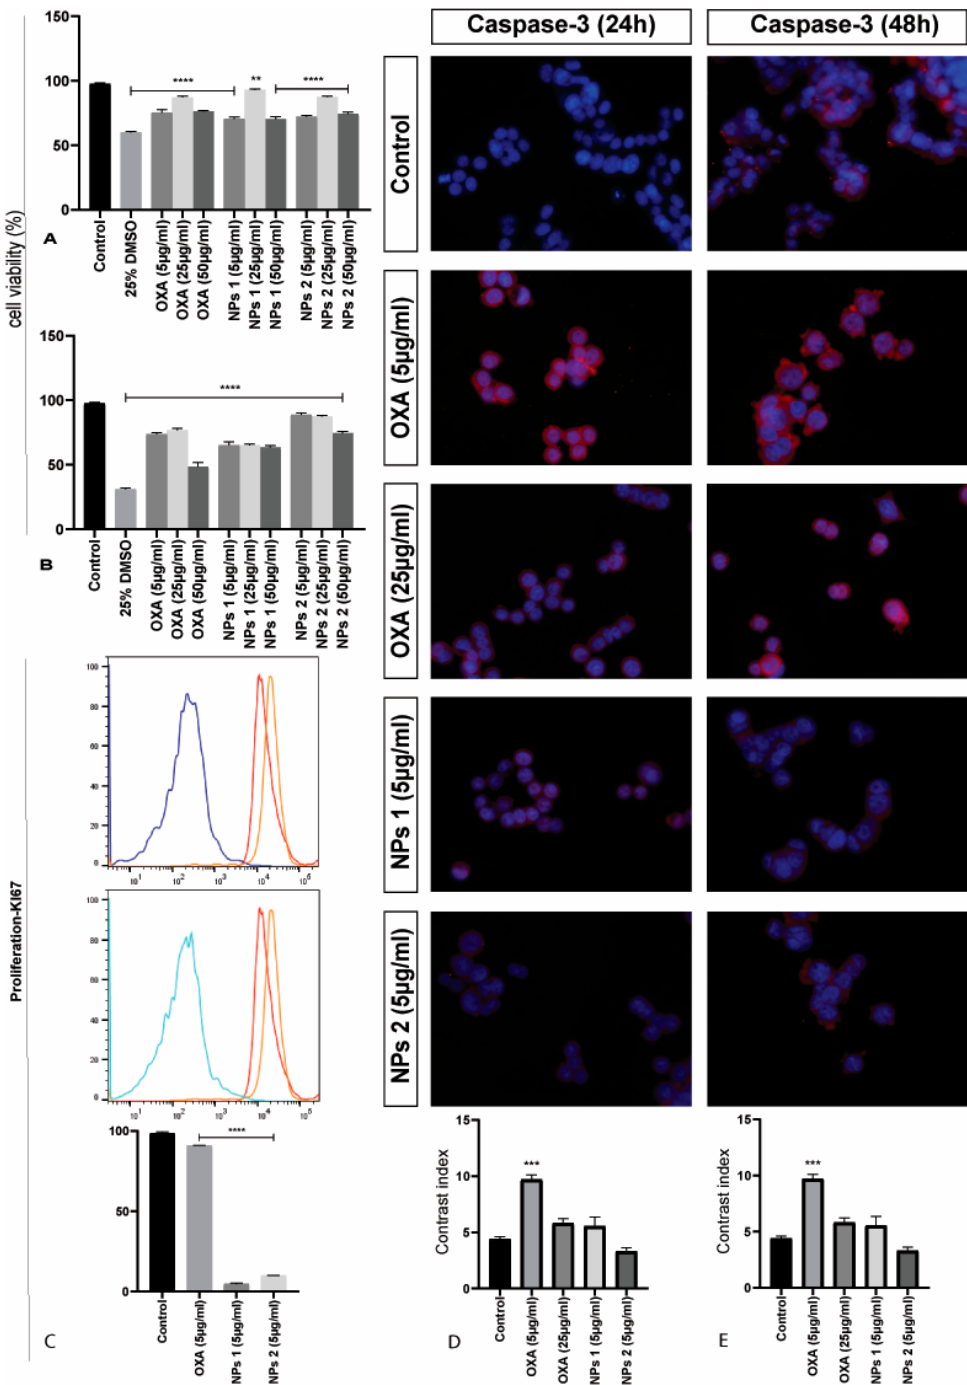
Figure 3. Cell viability, proliferation, and detection of caspase-3 of SW-480 cells. Mean cell proliferation of SW-480 cells treated with OXA and PLGA NPs for 24 h ( A ) and 48 h ( B ). All treatment groups were compared to the negative control group (**** p < 0.0001 and ** p < 0.01). Ki-67 immunostaining of SW-480 cells treated with OXA, NPs 1, and NPs 2, and compared to negative control for 48 h ( C ). All treatments were statistically significant (**** p < 0.0001). Representative photomicrographs of caspase-3 in SW-480 cells stained with 4,6-diamidino-2-phenylindole (DAPI) (blue) and anti-caspase-3 antibody (red). Contrast index for caspase-3 after 24 h ( D ) and 48 h ( E ) (*** p < 0.001). Scale bar: 50 μ m.